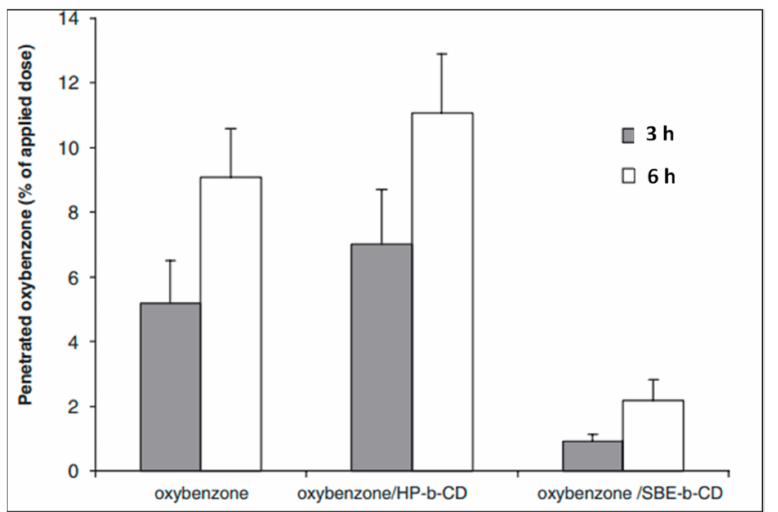
Figure 7. Penetration of oxybenzone across human epidermis to the receptor phase from solutions containing free or complexed sunscreen agent